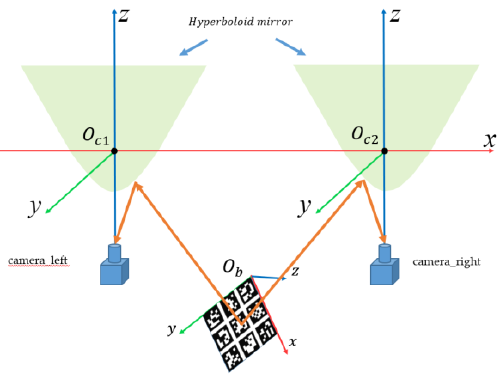
Figure 12. Schematic diagram of binocular stereo panoramic calibration.